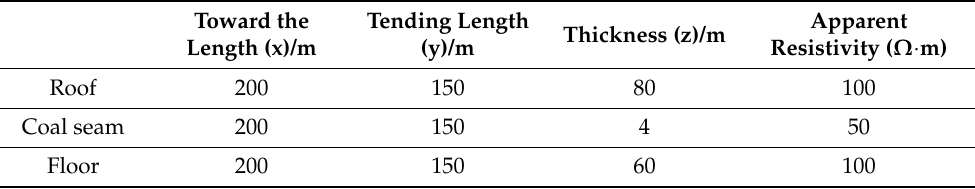
Table 1. Geoelectric parameters of the model.